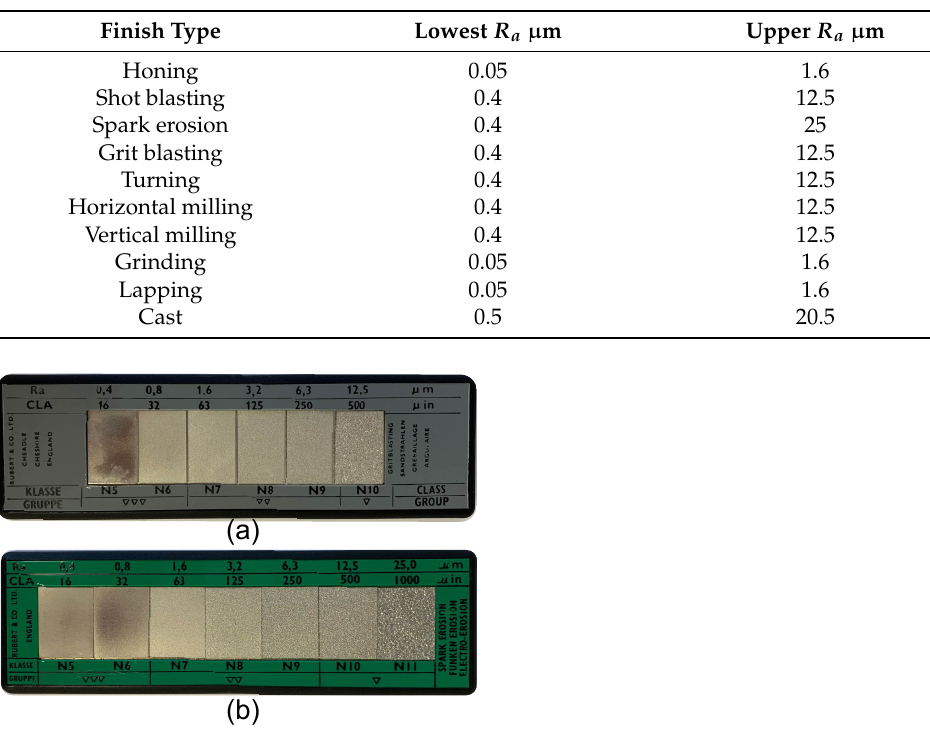
Figure 3. Photographs of two roughness comparators, ( a ) shot blast and ( b ) spark